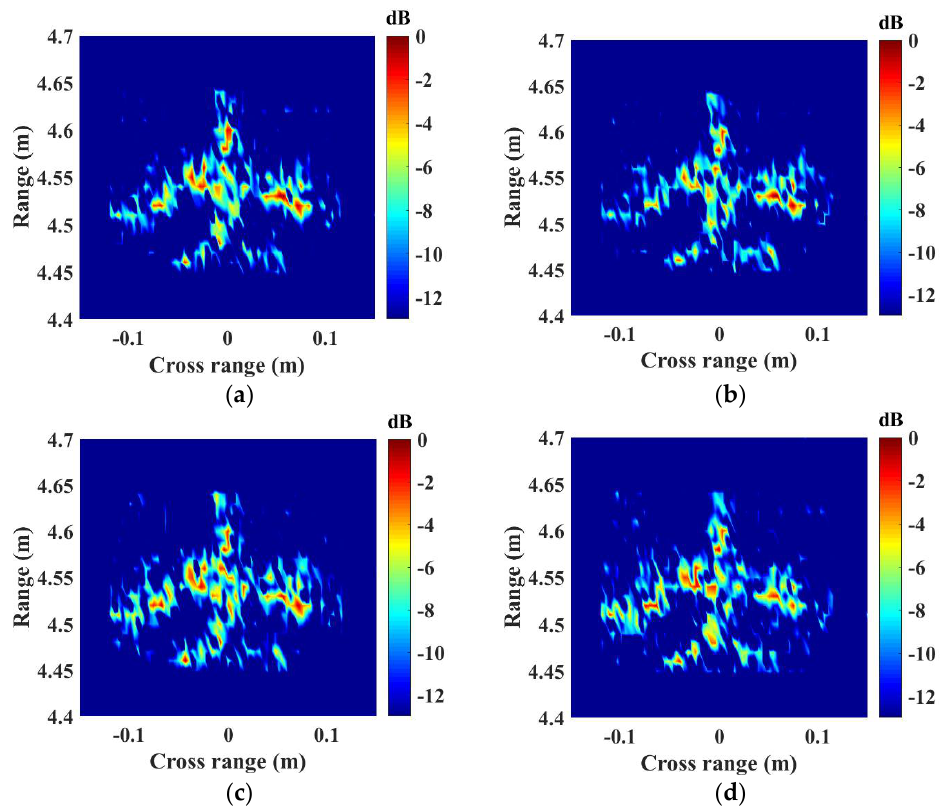
Figure 10. ISAR images of the plane model obtained by the ( a ) virtual sum signal, and receiving channels ( b ) Rx1, ( c ) Rx2, and ( d ) Rx4.